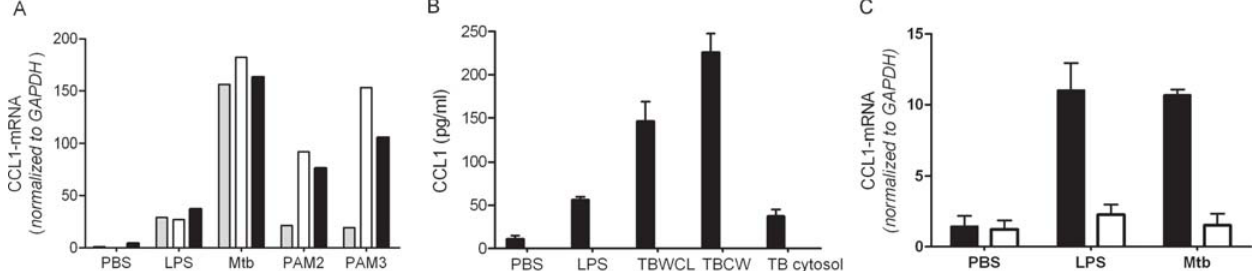
Figure 3. The cellular function of CCL1. (A) CCL1 mRNA expression in cells stimulated with Mtb and TLR ligands. Real-time PCR quantification of CCL1 in THP1 (grey columns), U937 (open columns), and PBMC (solid columns). Cells were stimulated with LPS (100 ng/ml), whole cell H37Rv Mtb lysates (50 m g/ml), and lipopeptides PAM2 or PAM3 (250 ng/ml). Cells were stimulated for 4 hours and mRNA was extracted and measured by real- time PCR. (B) CCL1 secretion in PBMCs stimulated with Mtb . PBMCs were stimulated with LPS (100 ng/ml), whole cell H37Rv Mtb lysates (50 m g/ml), TB cell wall (5 m g/ml), or TB cytosol (5 m g/ml). After stimulation for 24 hours, supernatants were assayed for CCL1 production by ELISA. Values represent mean and standard deviation of triplicate samples. Student’s t-test for comparisons between non-stimulated and either LPS, TBWCL, TBCW, or TB cytosol have P =0.002, 0.01, 0.006, and 0.02, respectively. (C) CCL1 expression in BMM from Myd88 2 / 2 (open columns) and wild-type mice (solid columns). BMM were stimulated with LPS (100 ng/ml) or Mtb (100 m g/ml) for 4 hours. Means of CCL1 expression examined in triplicate by real-time PCR are shown.